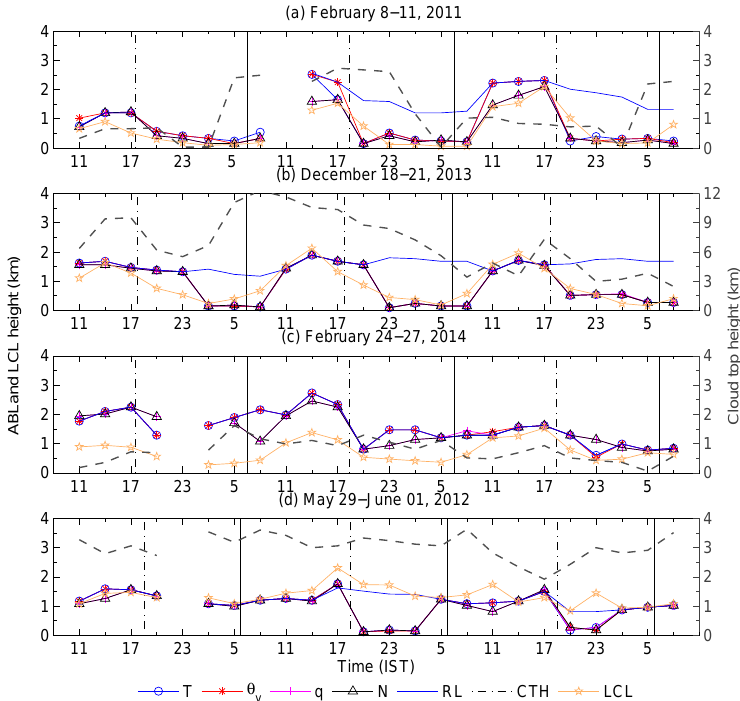
Figure 4. Diurnal variability of the ABL (CBL, SBL, and RL) height obtained from the variables T , θ v , q , and N during (a) 8–11 Febru- ary 2011, (b) 18–21 December 2013, (c) 18–21 February 2013, and (d) 29 May–1 June 2012. Thick dashed lines indicate the cloud top height (CTH). Yellow star lines indicate the lifting condensation level (LCL). Vertical dashed and solid bars indicate sunset and sunrise times,